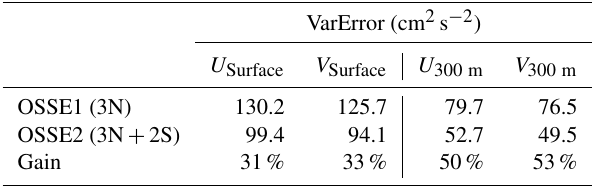
Table 3. Statistics for velocities at surface and 300m